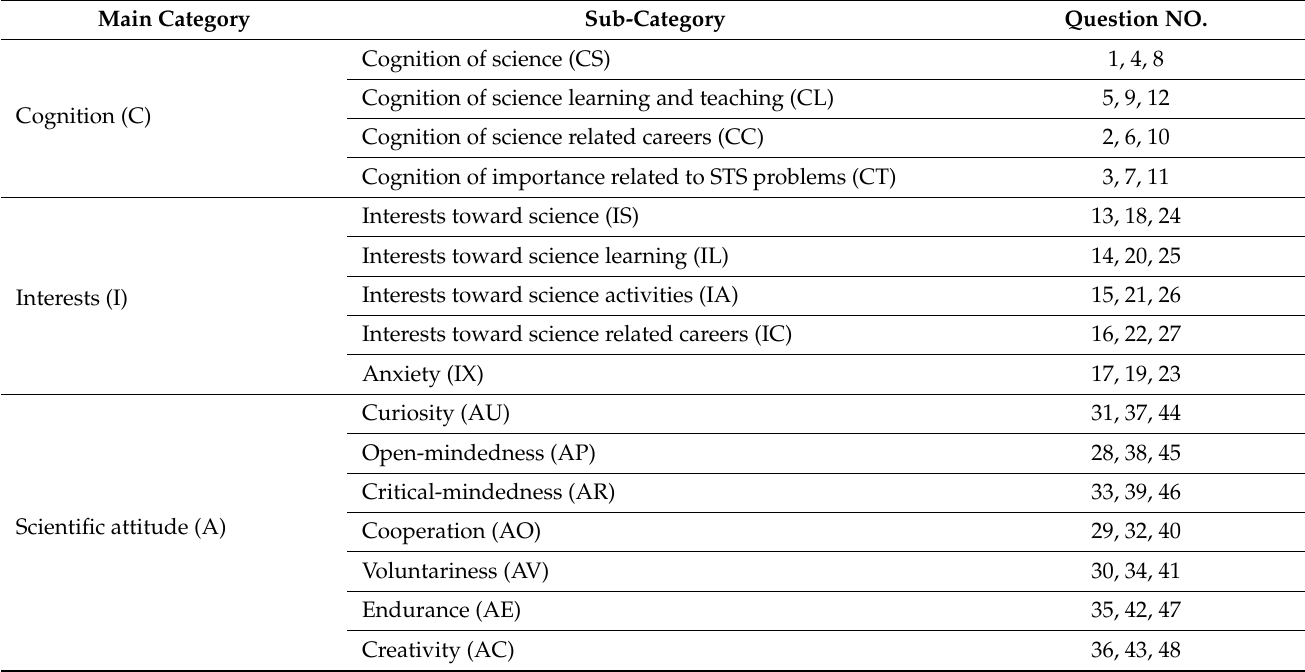
Table 2. Composition of the questionnaire on Cognition of, Interest in, and Scientific Attitude of Kim et al. (1998) [23]. Main